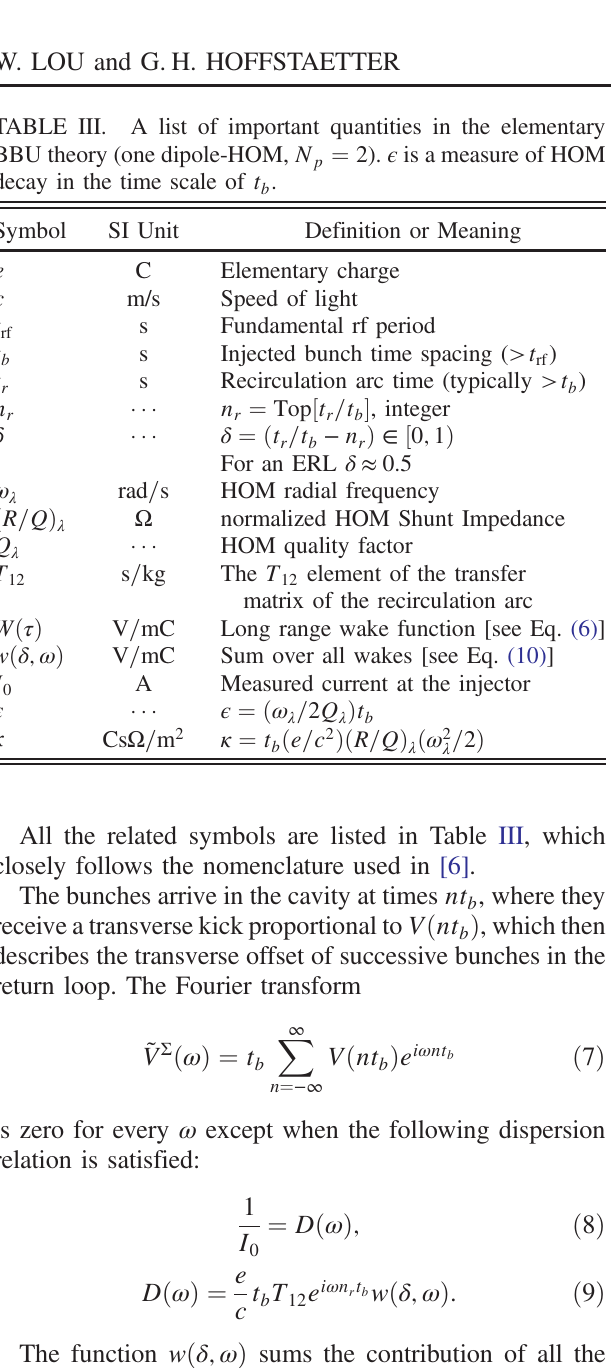
TABLE III. A list of important quantities in the elementary BBU theory (one dipole-HOM, N p ¼ 2 ). ϵ is a measure of HOM decay in the time scale of t b .